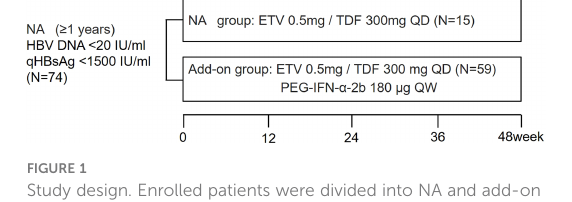
FIGURE 1 Study design. Enrolled patients were divided into NA and add-on groups according to their wishes. Blood samples were collected at study entry and every 24 weeks (NA group) or every 12 weeks (add-on group). NA, nucleos(t)ide analogs; qHBsAg: quantitative hepatitis B surface antigen; ETV: entecavir; TDF, tenofovir disoproxil fumarate; PEG-IFN- a -2b, Pegylated-interferon-alpha- 2b; QD: once daily; QW: once a